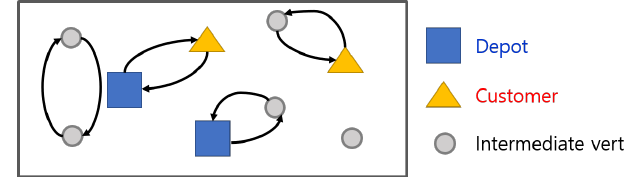
Figure 2. Examples of